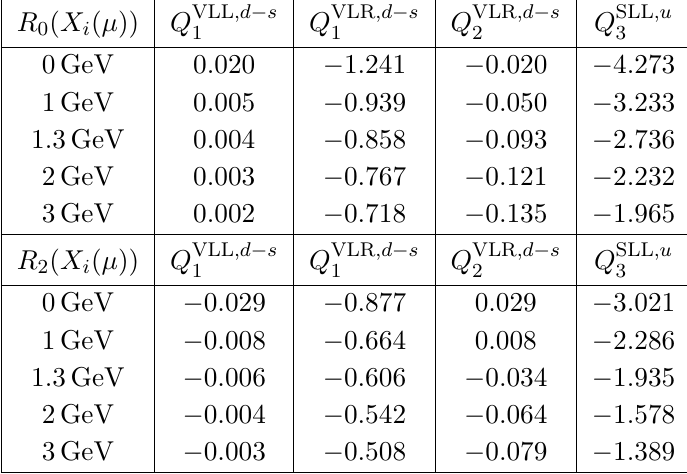
Table 8 . Ratios R I of BSM operators in the SD basis allowed by SMEFT over ^ Q 8 contributing to the isospin amplitudes A 0 ; 2 for four values of (cid:22)